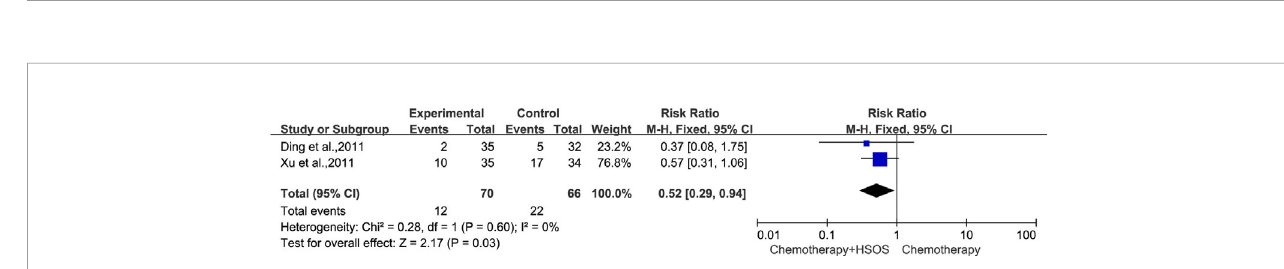
FIGURE 8 | Forest plot of platelet toxicity with chemotherapy combined with HSOS versus chemotherapy alone.